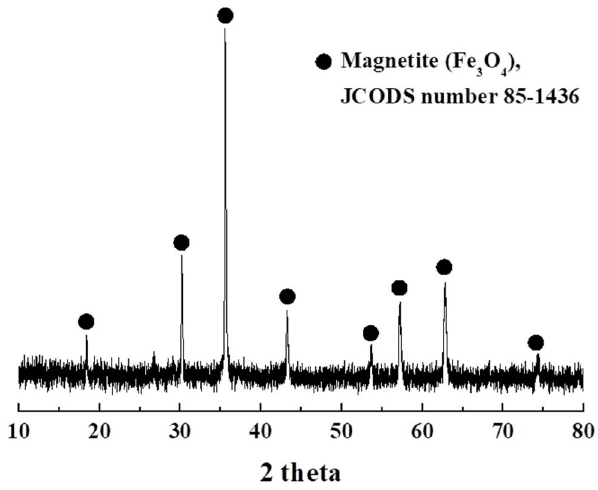
Figure 3. XRD-patterns of the simulated corrosion oxide layer on the specimens.